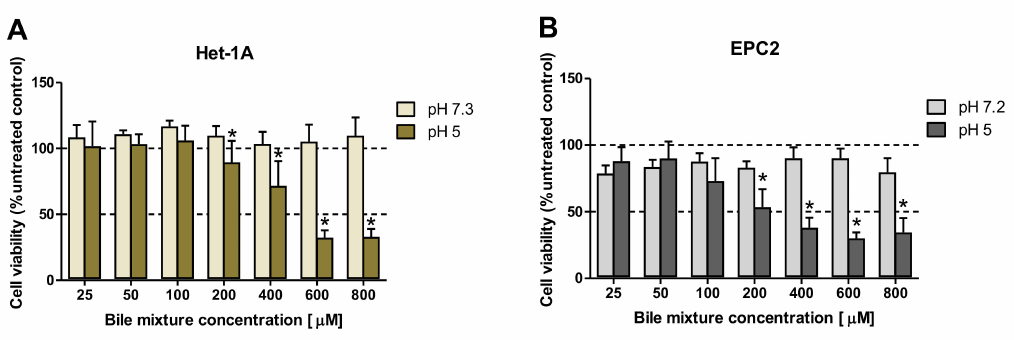
Figure 1. The e ff ect of exposure to various concentrations of bile mixture (BM) and di ff erent pH on the viability of esophageal epithelial cell lines. Het-1A ( A ) and EPC2 ( B ) cells were treated for 30 min with BM at concentrations ranging from 0 to 800 µ M. After 24 h, MTT assay was used to determine cell viability. Significant changes ( p < 0.05) in cell viability after BM treatment at pH 5.0 as compared to the treatment with BM in regular medium were indicated by asterisk